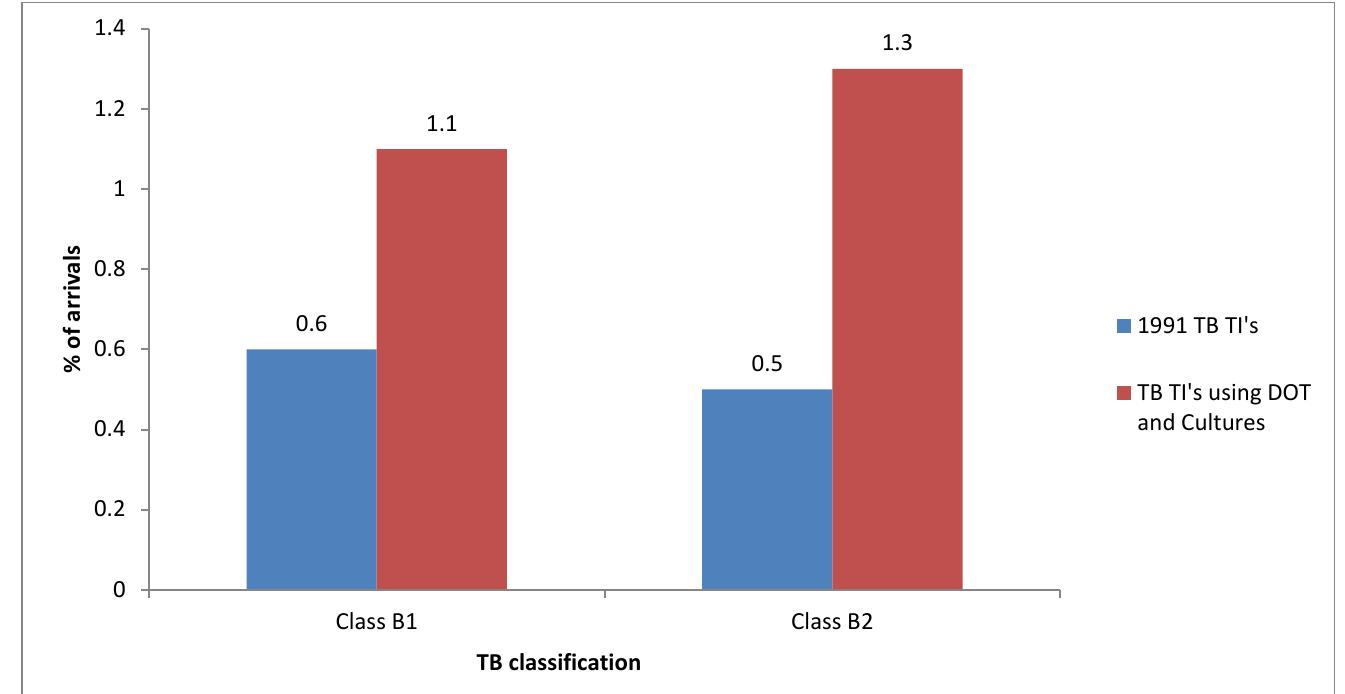
Figure 10: Overseas TB classifications using the 1991 TB Technical Instructions and the 2007 TB Technical Instructions using directly observed therapy (DOT) and cultures for Congolese refugees who resettled in the United States from 2008 – 2013